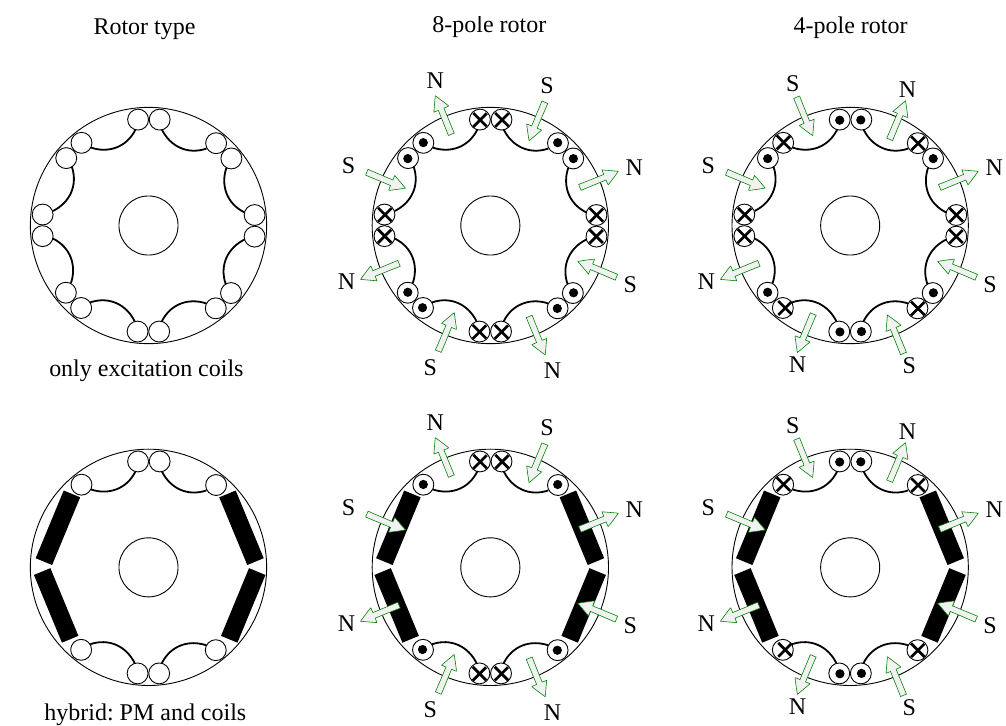
Figure 8. Sketch of the rotor change in polarity from eight-pole to